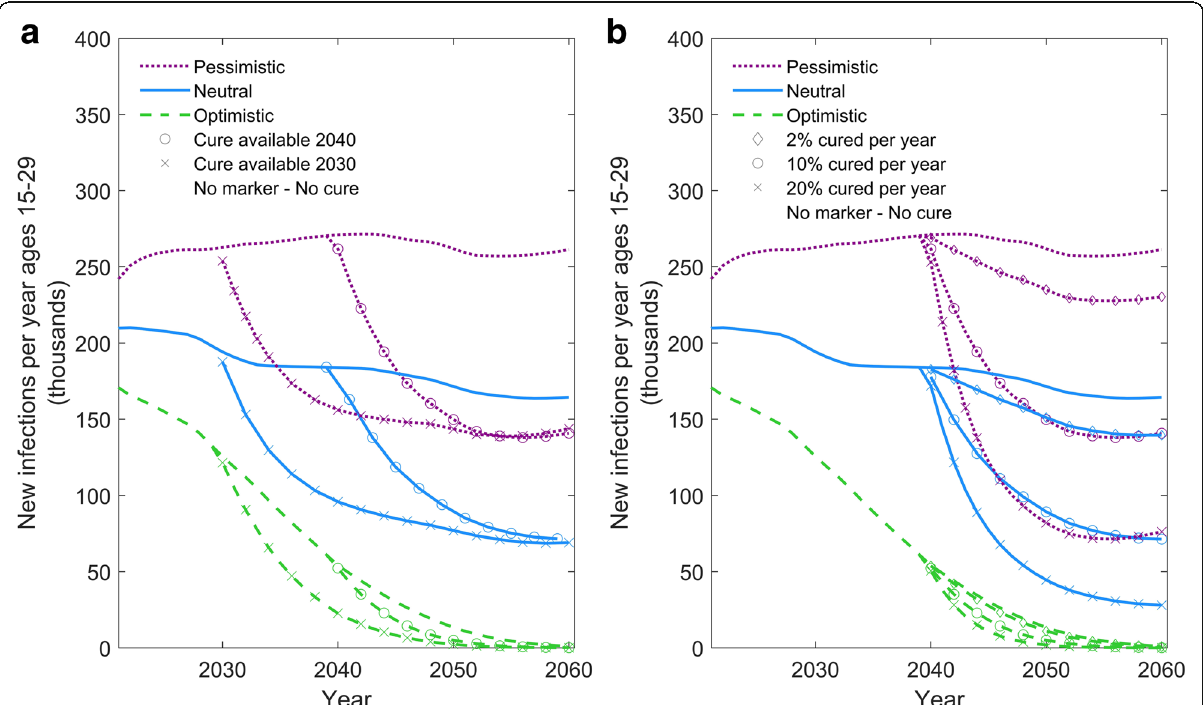
Fig. 2 Timing and pace of scale-up. a Comparison of two scenarios in which a curative intervention becomes available either in 2040 (baseline) or in 2030. b Comparison of different roll-out rates for an intervention in which either 2, 10%, or 20% of eligible HIV-infected individuals are cured per year . In both panels, the y-axis shows the number of individuals aged 15 – 29 newly infected with HIV per year. The green dashed, blue solid, and purple dotted lines represent the optimistic, neutral, and pessimistic epidemic forecasts, respectively (see Table 1). The symbols on the line denote the alternative scenarios for the cure